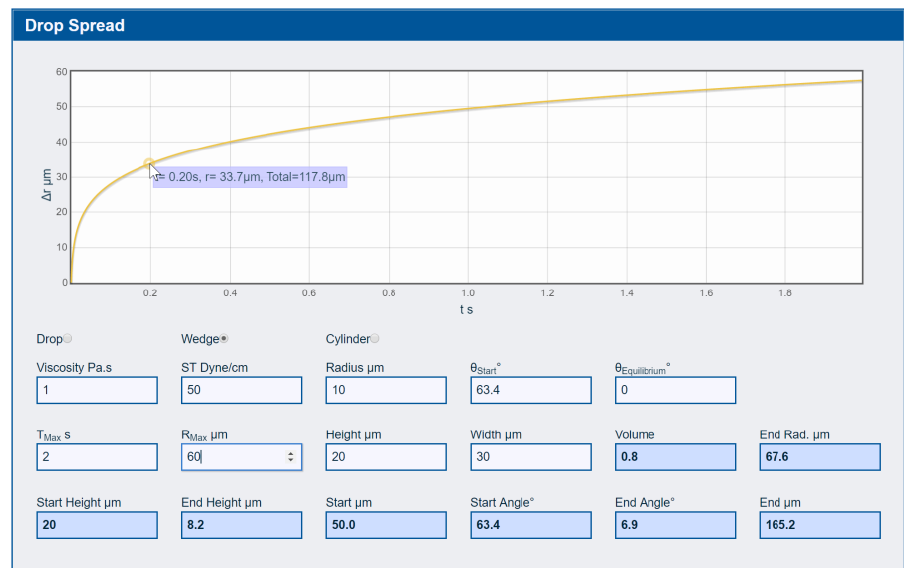
Figure 5. What should be a 50 μm line becomes 118 μm after only 0.2 s, with an increase to 165 μm over 2 s. The rapid initial spreading in a 1 Pa·s ink is surprising to most of us. The app is at www.stevenabbott.co.uk/practical-coatings/drop-spread.php.